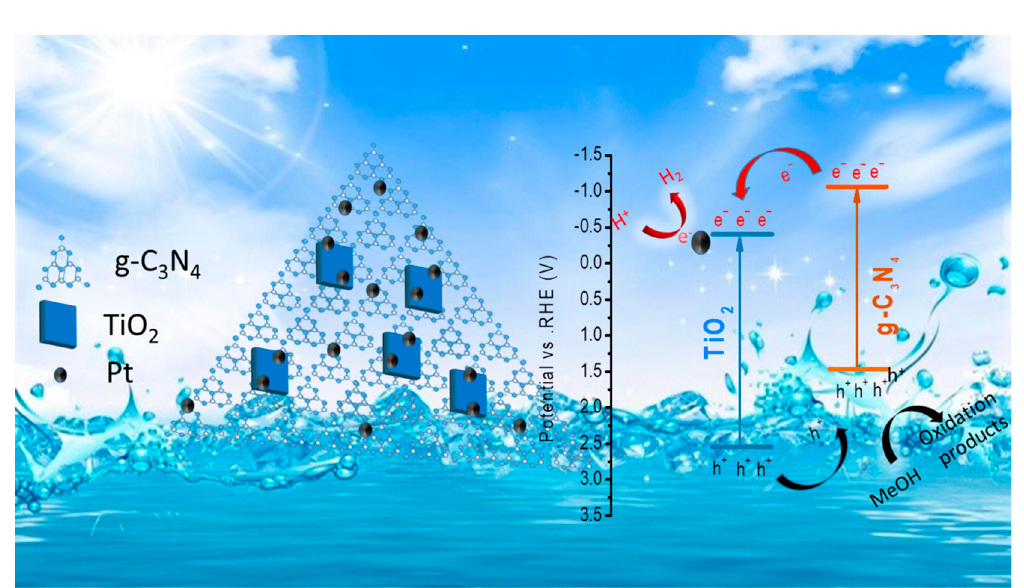
Figure 7. Schematic diagram of photocatalytic hydrogen production over T/uCN photocatalyst.